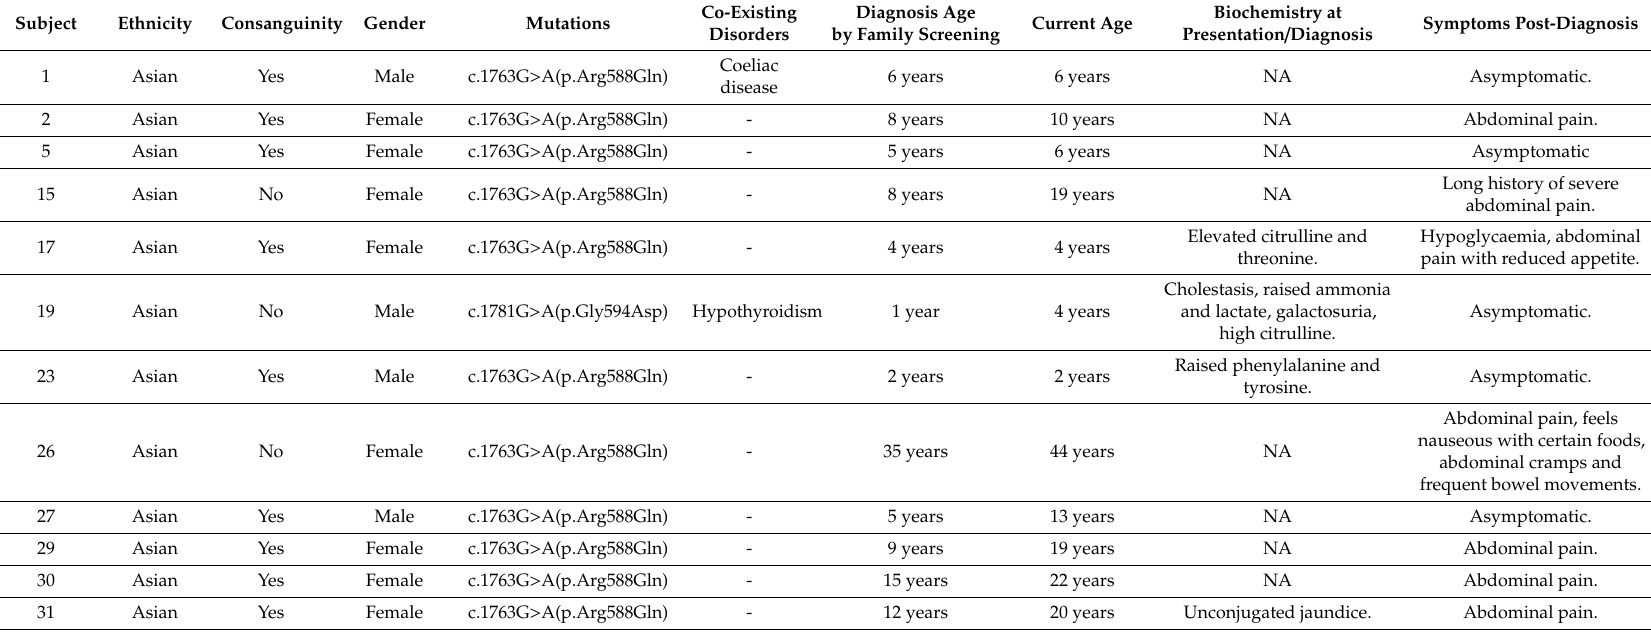
Table 4. Demographics, genetic results and symptoms on presentation for patients diagnosed by family